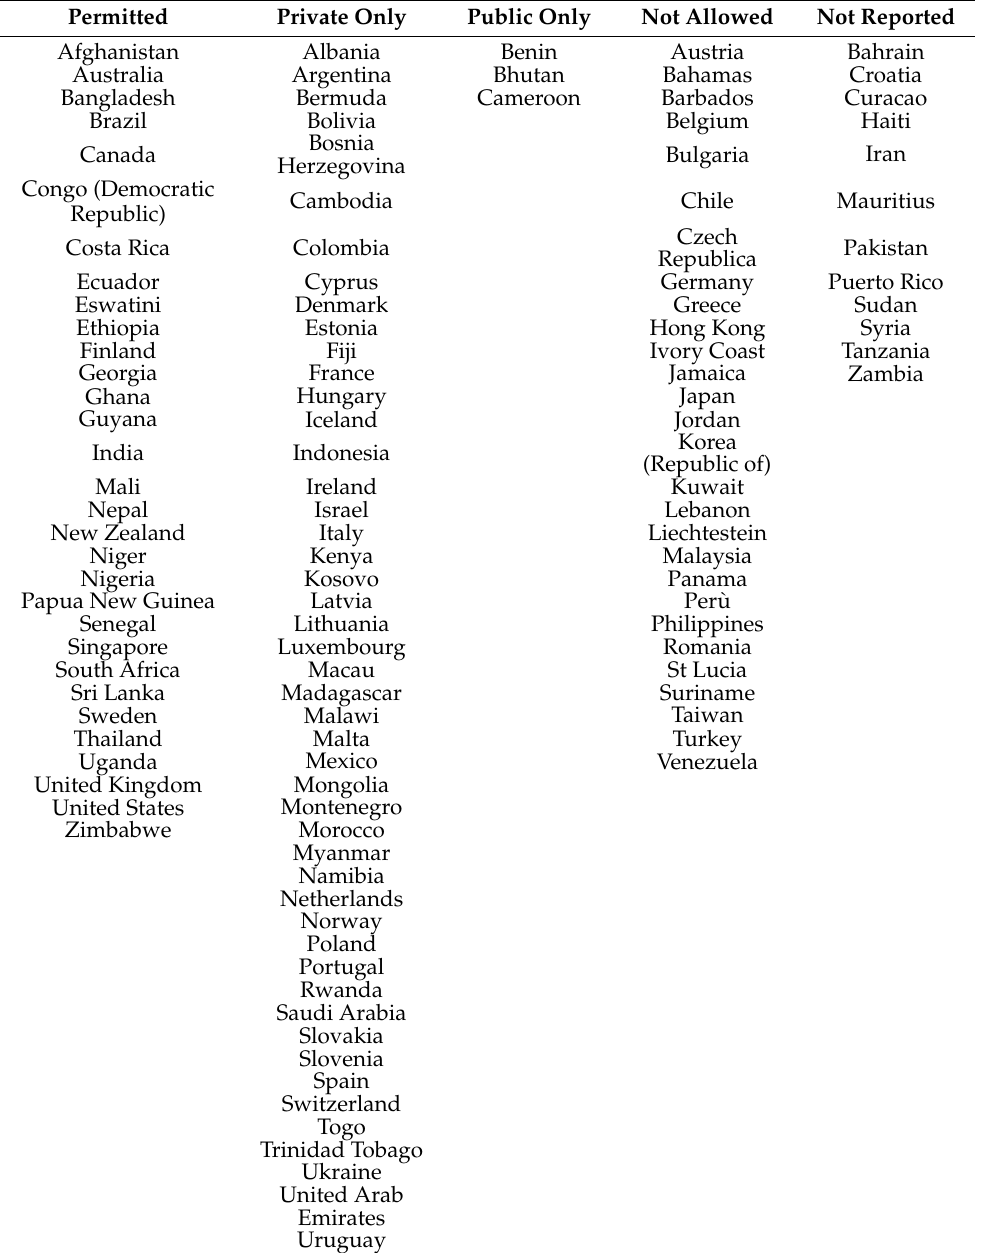
Table 1. All countries belonging to World Physiotherapy offering direct access